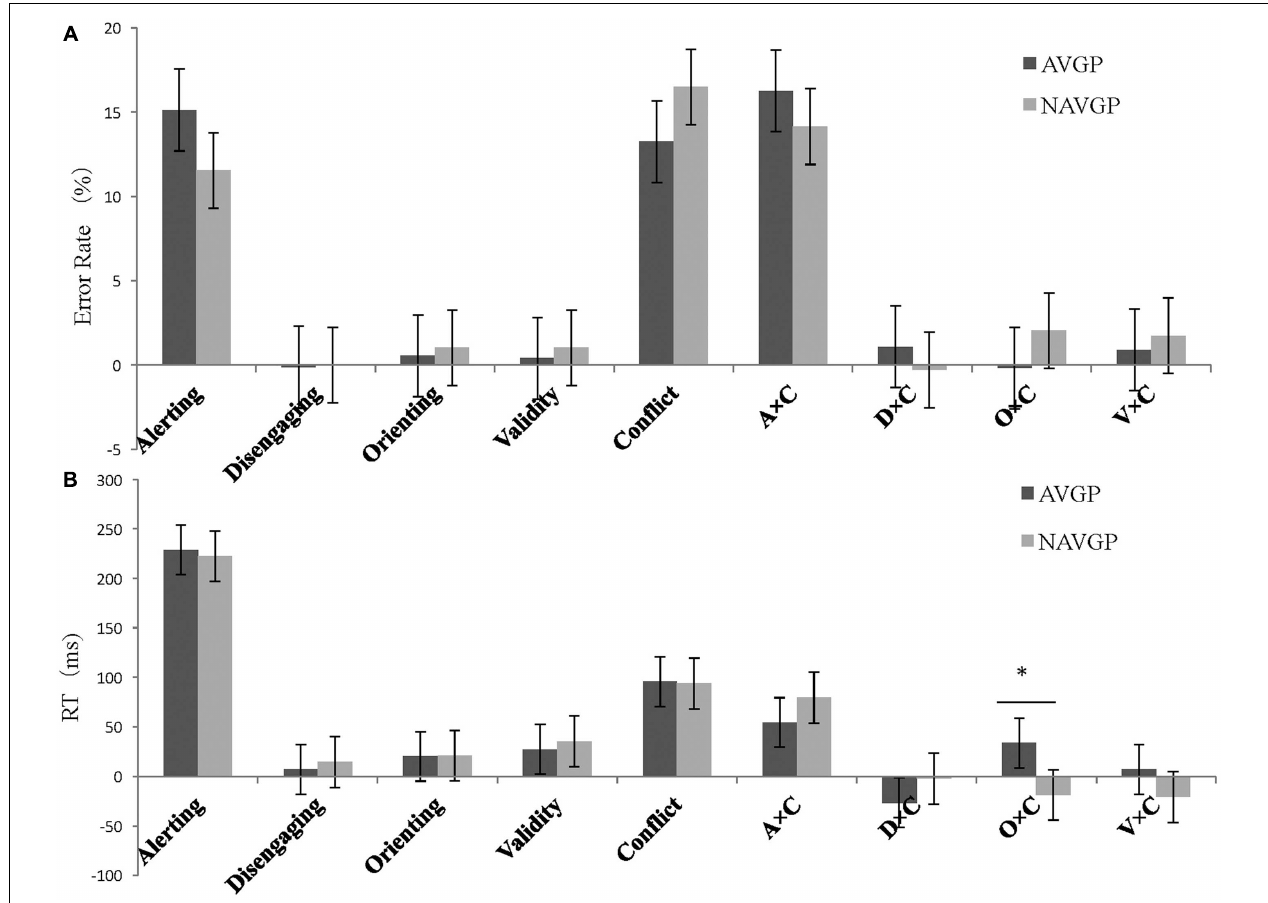
FIGURE 5 | (A) Error rate (ER, %) and (B) Reaction time (RTs) as a function of the attentional effects for different groups in the ANT-A. Error bars represent the standard error of the mean. A × C, alerting by conflict; D × C, disengaging by conflict; O × C, orienting by conflict; V × C, validity by conflict. ∗ p < 0.05.